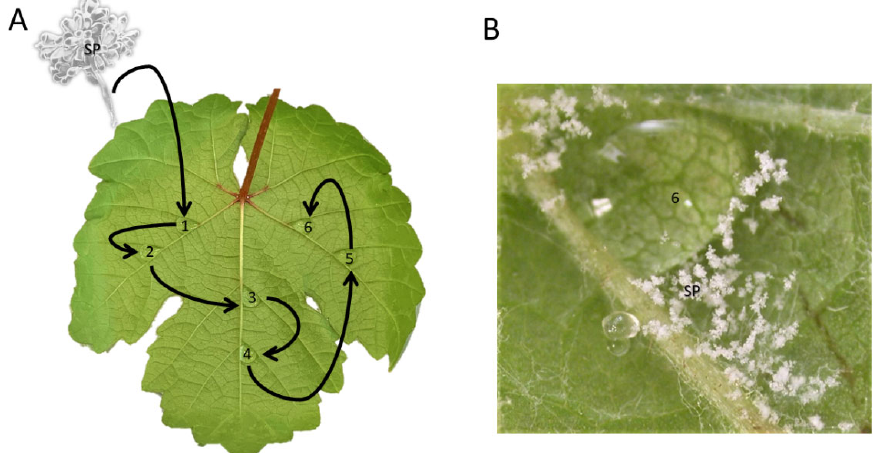
Figure 5. P. viticola isolation procedure. ( A ) An individual sporangiophore (SP) was inoculated in a 25 µ L water droplet (droplet n.1) and serially diluted five times (until droplet n.6). ( B ) Seven days after incubation of the inoculated leaf at 22 °C (16 h of light/day), sporangiophores (SP, in white) were taken from the last droplet (n.6) and inoculated on fresh leaves to propagate the isolate.